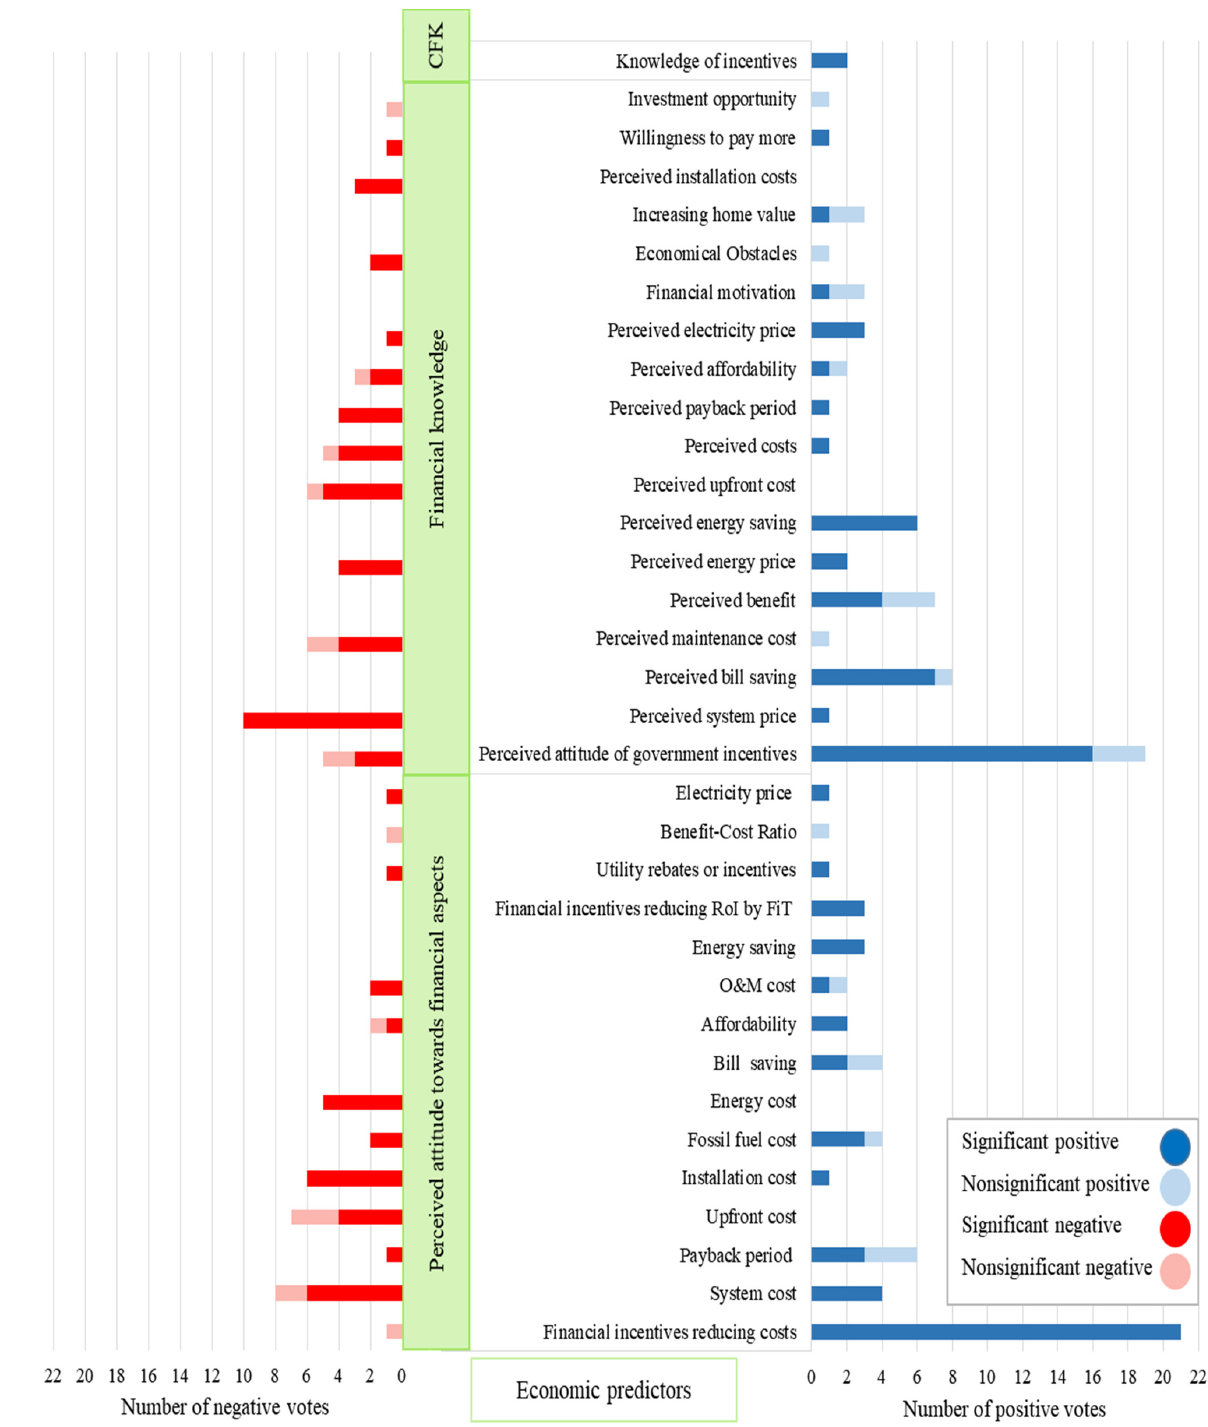
Figure 6. Vote-counting results for financial variables affecting solar system adoption by households. Results are narrowed to variables studied in at least two studies.